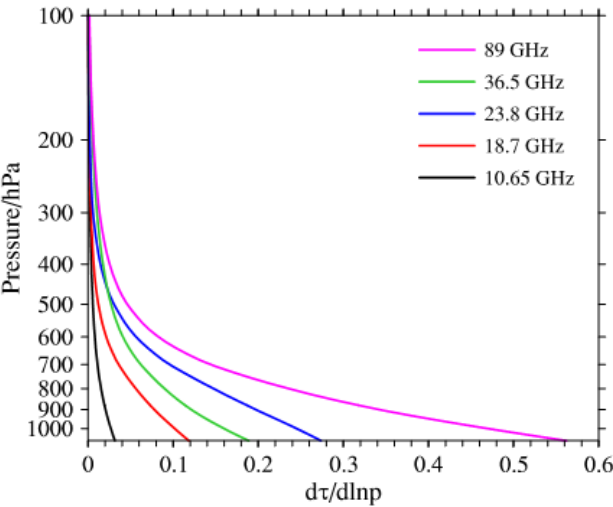
Figure 2. The weighting function of the MWRI .